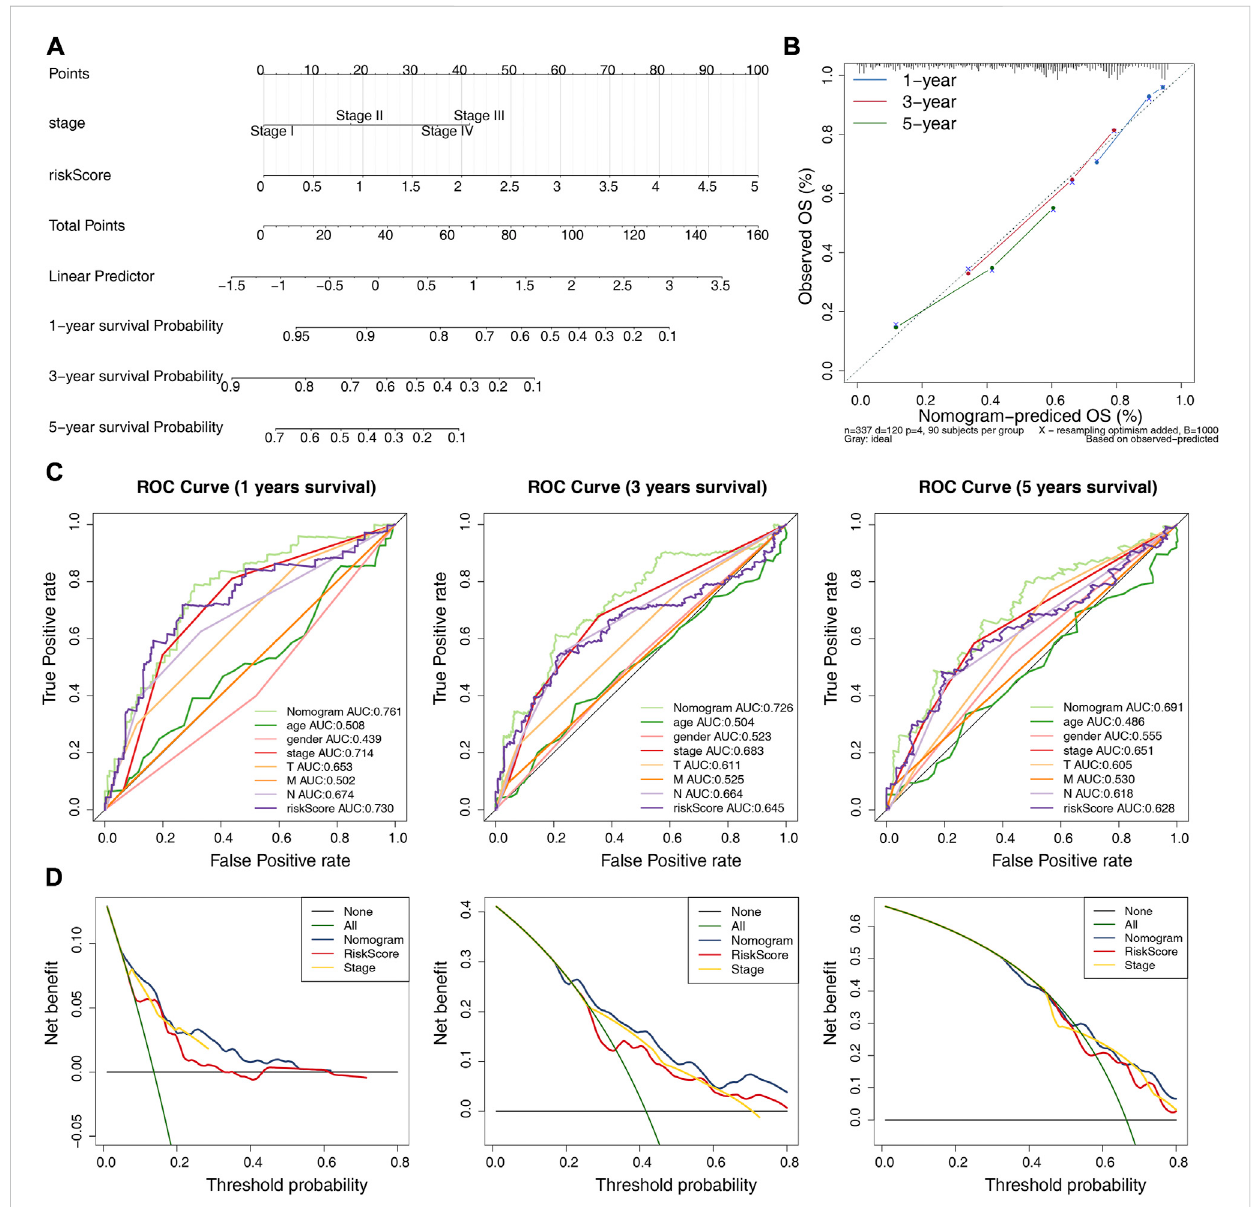
FIGURE 6 Establishment and validation of a nomogram. (A) A nomogram based on the riskscore and independent prognostic factors. (B) Calibration curve for thenomogram. (C) ROCcurvesofthenomogramandclinicalcharacteristics(Nandstage)at1-,3-,and5-year. (D) DCAcurveofthenomogramat1-,3-, and